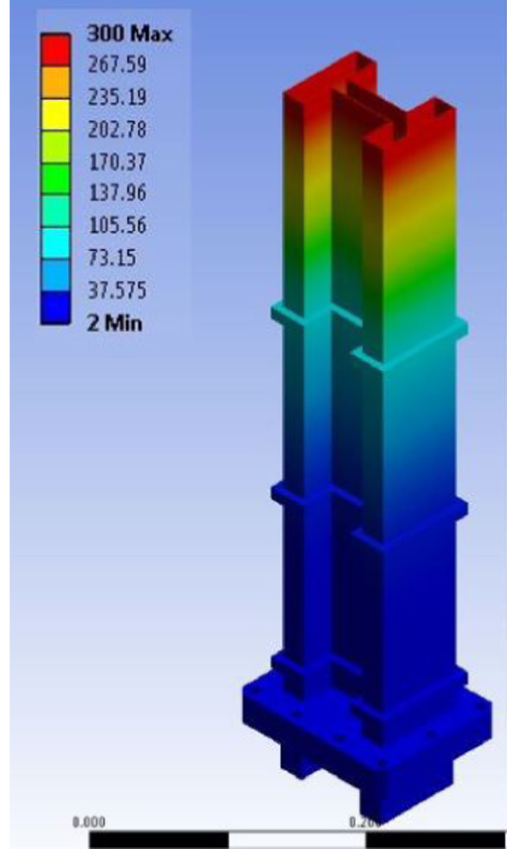
FIG. 8. Temperature distribution obtained numerically.